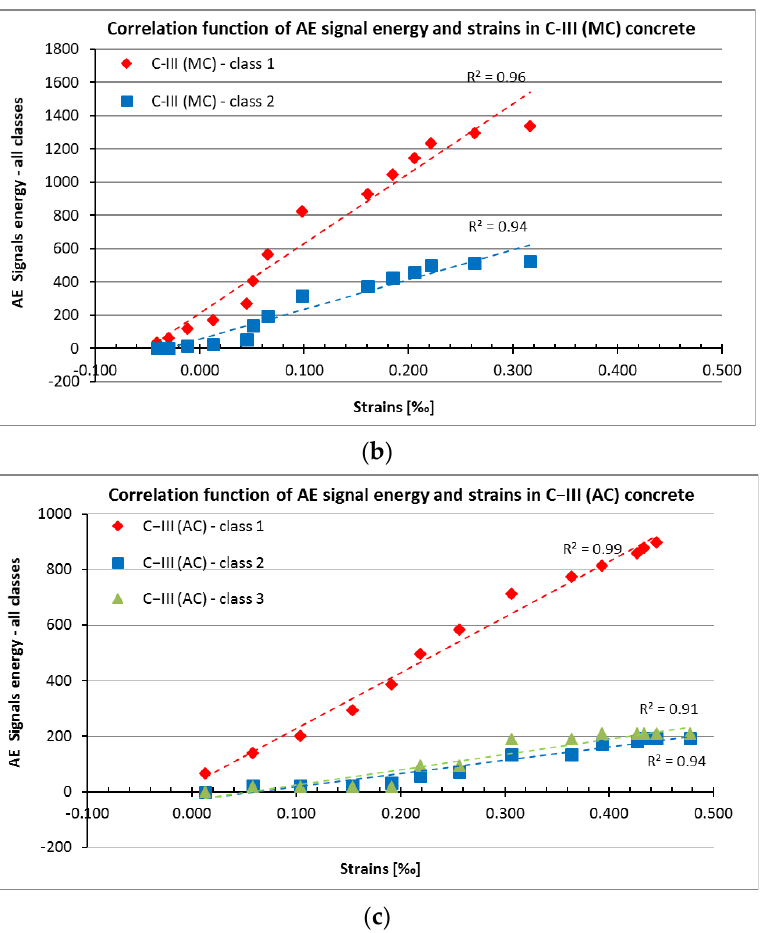
Figure 10. Correlation functions of AE signals energy and strains in samples subjected to curing ( a ) C − I (MC), ( b ) C − III (MC), and ( c ) C − III (AC) (without prior curing).